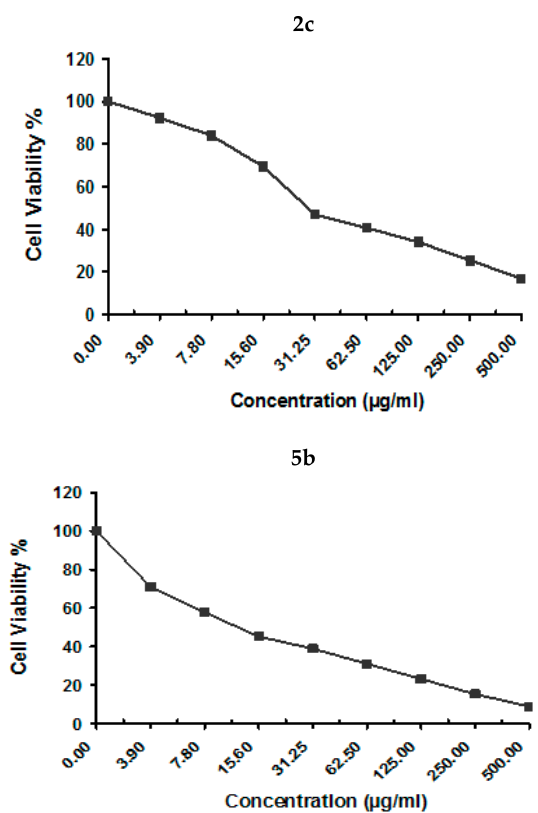
Figure 6. The viability values of the most active thiazoline derivatives against HCT-116 cell line.